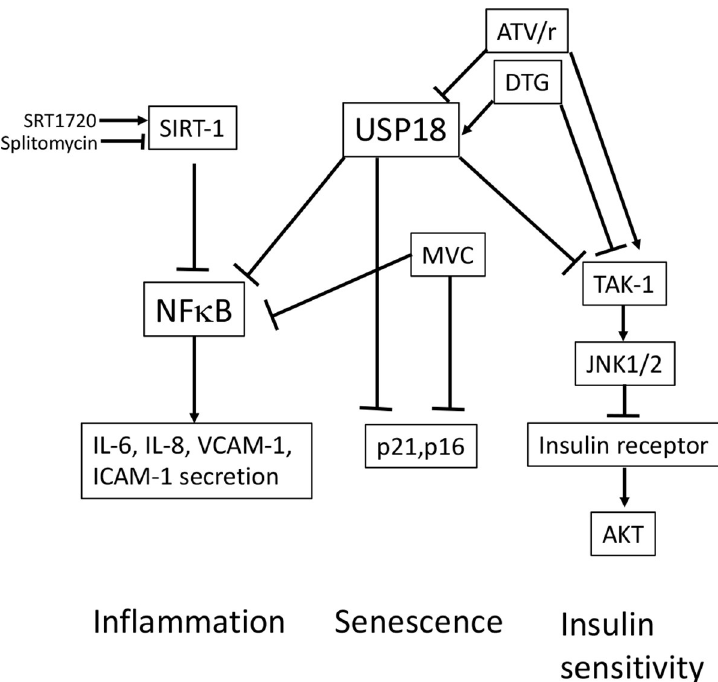
Fig 13. Hypothetical view of the signaling pathways used by DTG, MVC and ATV/r to alter inflammation, senescence and insulin sensitivity in coronary artery endothelial cells. We propose that USP18 is differently involved in inflammatory, senescence and insulin-sensitizing pathways. The effects of DTG and ATV/r on inflammation and senescence could involve USP18 but not their effects on insulin sensitivity. MVC signals on inflammation and senescence independently of USP18 and does not modify insulin sensitivity. The possible relationships between inflammation and senescence need to be further evaluated.